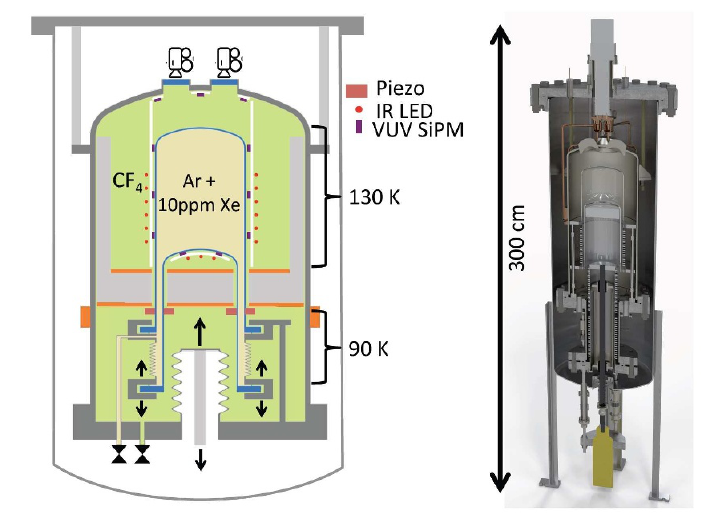
Figure 11 . Schematic and model of a 10-kg LAr bubble chamber under construction, showing pressure and temperature control, bubble imaging, and scintillation detection scheme. The design is of a \right side up" type, as in [123] and the upcoming PICO-40 and PICO-500 chambers